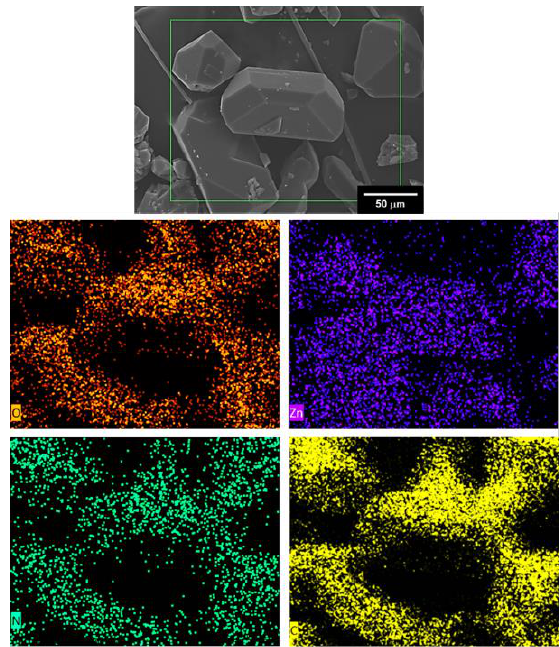
Figure 7. Representative SEM images of compound 1 showing its typical crystal sizes ( A and B , respectively).